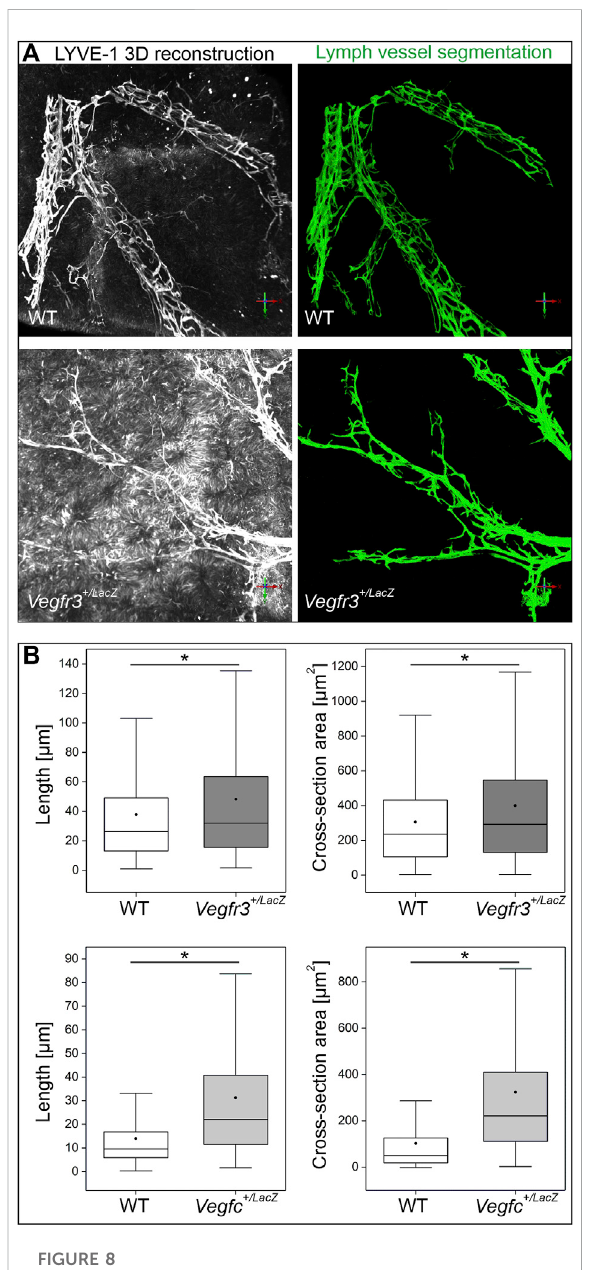
FIGURE 8 Quanti fi cation of lymphatic vascular networks in Vegfc +/LacZ , Vegfr3 +/LacZ and respective wildtype livers. (A) : Representative 3D reconstructions from LYVE-1 signal in whole mount preparations and their respective segmentation volumes after computational analysis. (B) : The segmentation of the lymphatic network was skeletonized and quantitative features were extracted from the underlying graph structure. Vegfr3 +/LacZ and Vegfc +/LacZ livers showed signi fi cantly longer vascular segments betweenbranchingpointsandhigheraveragecross-sectionareas. Asterisks indicate a signi fi cant result in statistical testing (Mann- Whitney-U hypothesis testing, p <